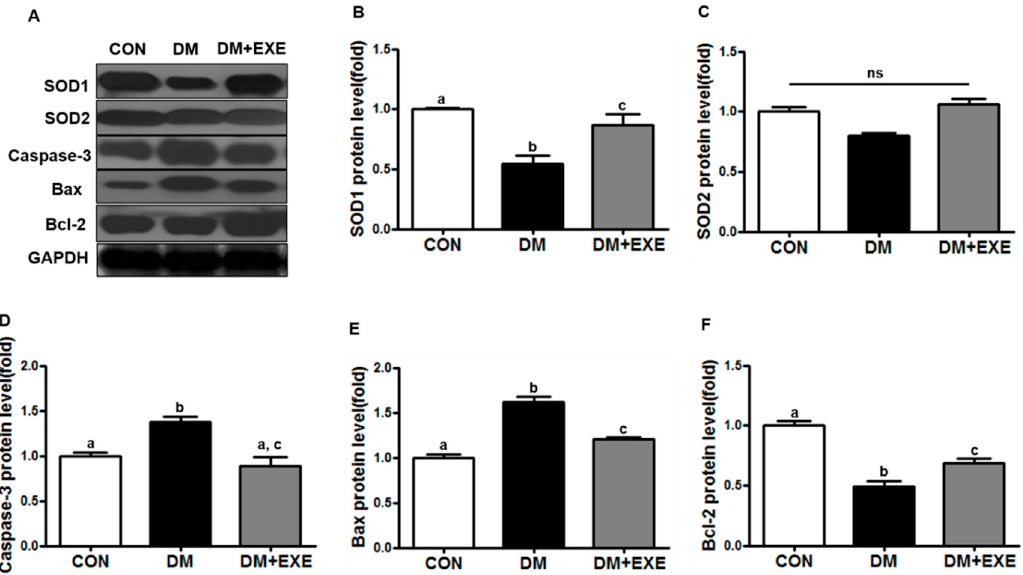
Figure 5. Resistance exercise training improved antioxidant enzymes and apoptosis protein levels such as, caspase-3 and Bax/Bcl-2 in the hypothalamus of T2DM rats. All data are presented as the Mean ± SD. ( A ) representative western blotting band, ( B ) superoxide dismutase 1 (SOD1), ( C ) superoxide dismutase 2 (SOD2), ( D ) Caspase 3, ( E ) BCL2-associated X protein (Bax), ( F ) B-cell lymphoma 2 (Bcl-2). CON: non-diabetic control group; DM: diabetic control group; DM + EXE: diabetic with resistance exercise training group. a, b, c Different letters indicate a significant difference between groups ( p < 0.05). ns: not significant.